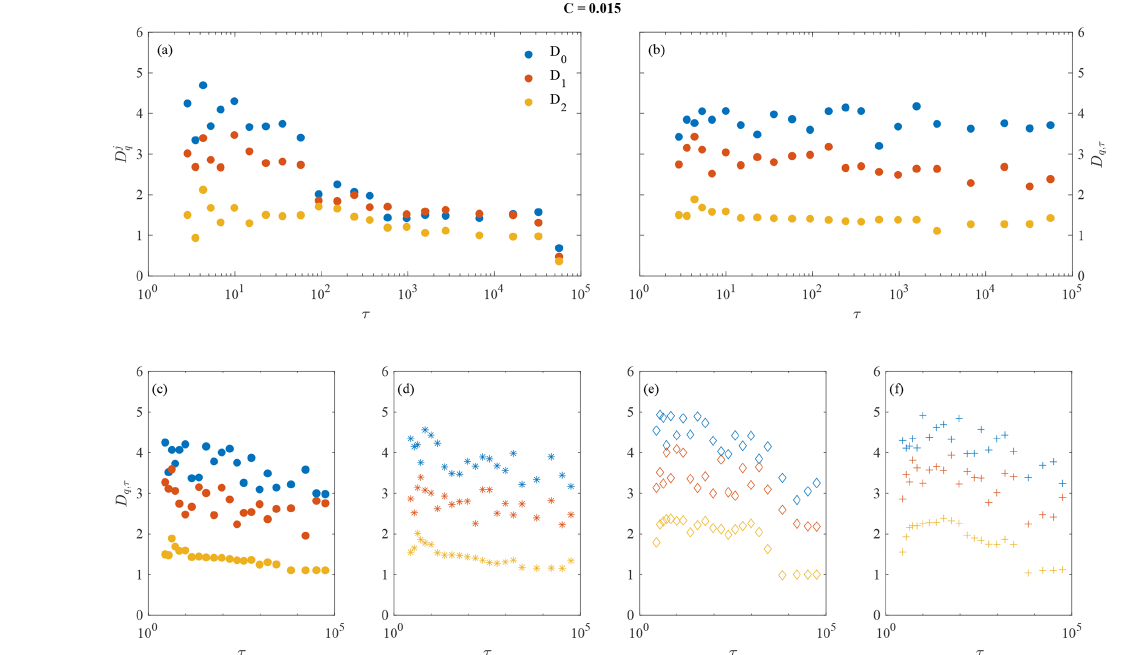
Figure 8. Same as in Fig. 7, but for C = 0 .